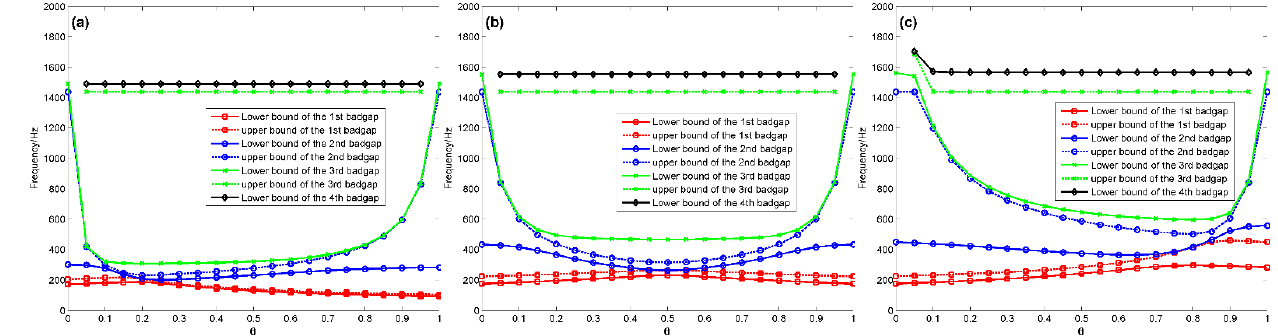
Figure 6. Lower and upper borders of the bandgaps for the infinite coupling strut: ( a ) as a function of ς when θ = 0.25 and η = 0.5; ( b ) as a function of ς when θ = 0.5 and η = 1; ( c ) as a function of ς when θ = 0.75 and η = 2. Next, the band diagrams are displayed in Figures 7 and 8, where the variation of